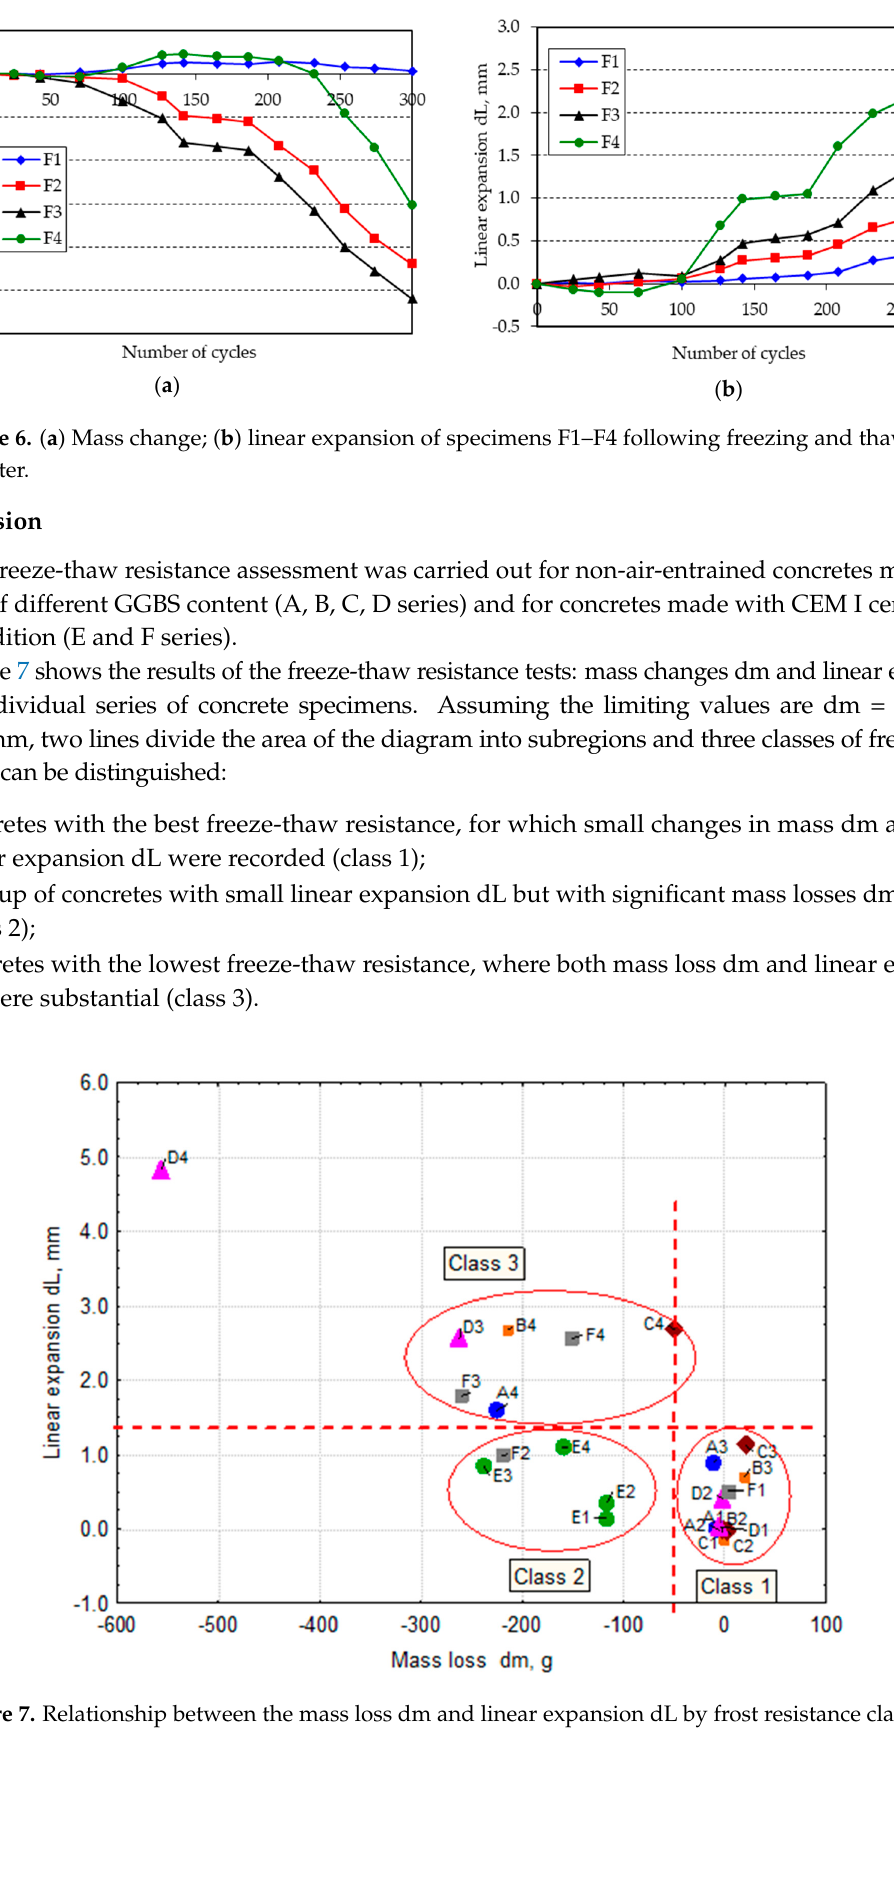
linear expansion dL from 1.60 to 4.83 mm. When the GGBS addition is used, the analysis of pore size distribution indicates a lower capillary pore content and a general reduction in the average pore size. As a result, high pressures are generated that damage the concrete structure. The specimens are frozen in water and the continuous contact with water allows the supply of additional water from the outside and an increase in the degree of saturation. This leads to the ice lens formation and, as a result of cyclic freezing-thawing, to the phenomenon of micro-ice-lens pumping. Passing the critical degree of saturation, even locally, is the major factor in microcrack formation, which, as freeze-thaw cycles continue, leads to the opening of the initially tight structure, taking up an additional amount of water, and as a result, to the failure of the concrete structure. In the early stage of deterioration, the mass of concrete first increases then decreases due to mass losses. The change in mass dm after 300 freeze-thaw cycles depending on the w/b ratio and the slag content is shown in Figure 8. In the case of concretes with the slag content lower than 30%, there is a